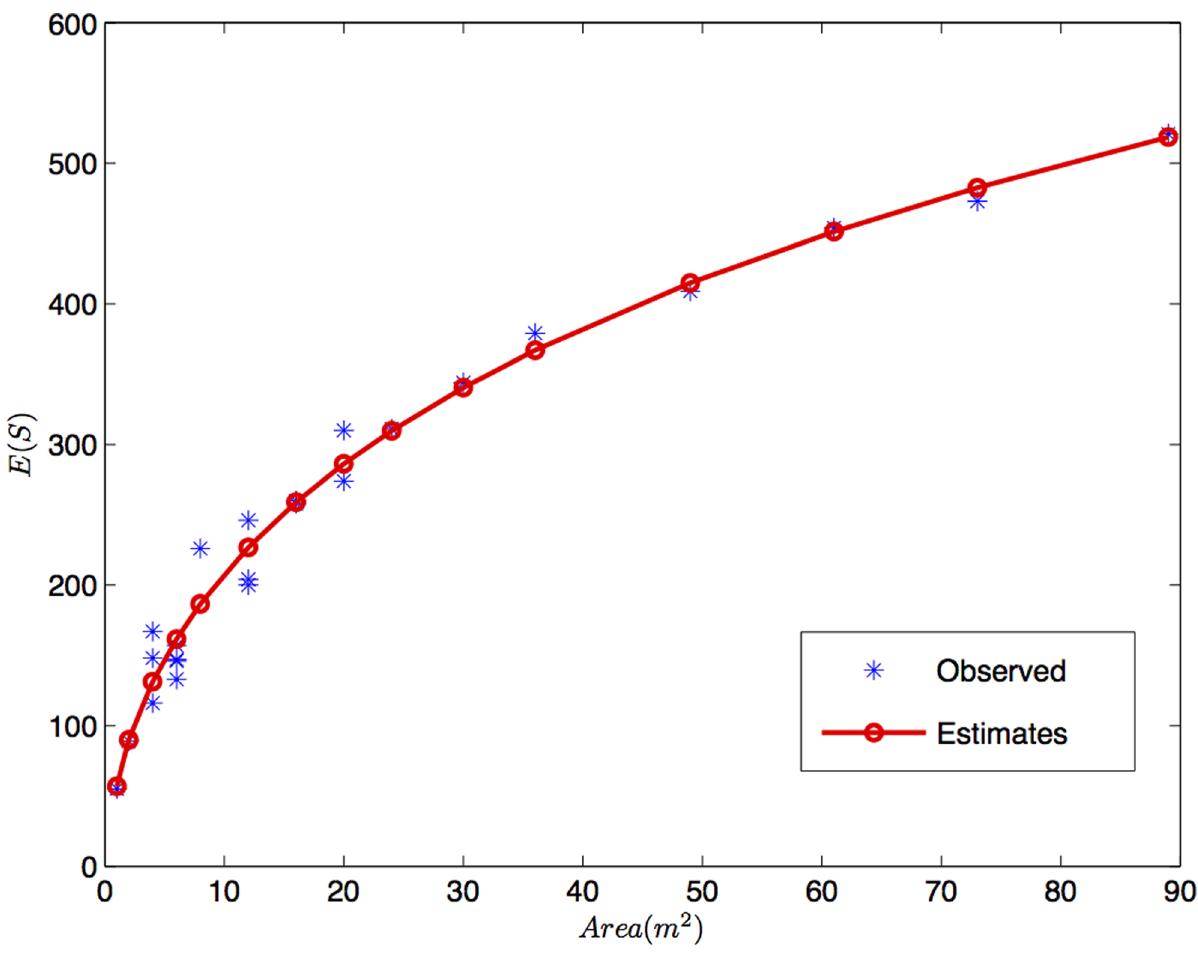
Figure 2. Data and fitted model for the real species-area relationship of Hymenoptera in a beech forest on limestone.